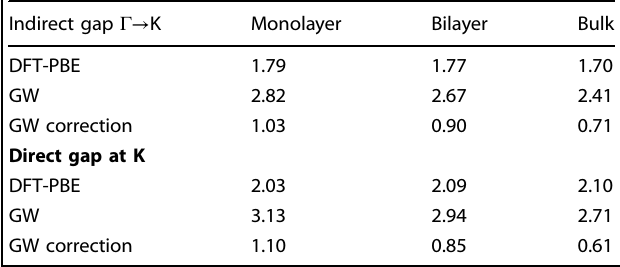
Table 3. Layer-dependent direct and indirect quasiparticle band gaps (in eV) of MoSi 2 N 4 calculated within the GW approximation.